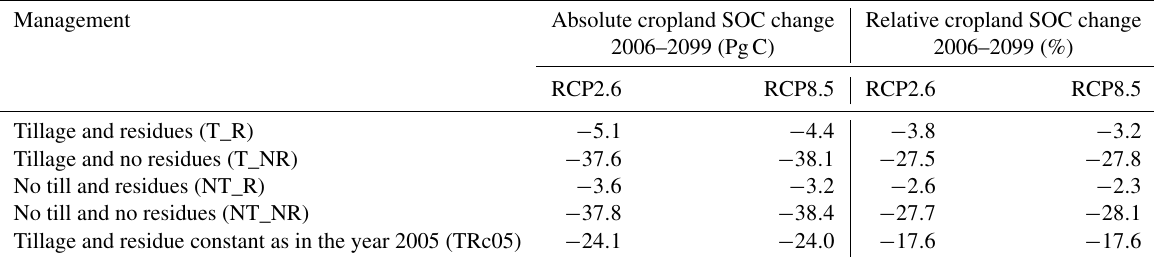
Table 3. Summary of absolute and relative global cropland SOC stock change between the years 2006 and 2099 for different management systems for RCP2.5 and RCP8.5 as averages across all four